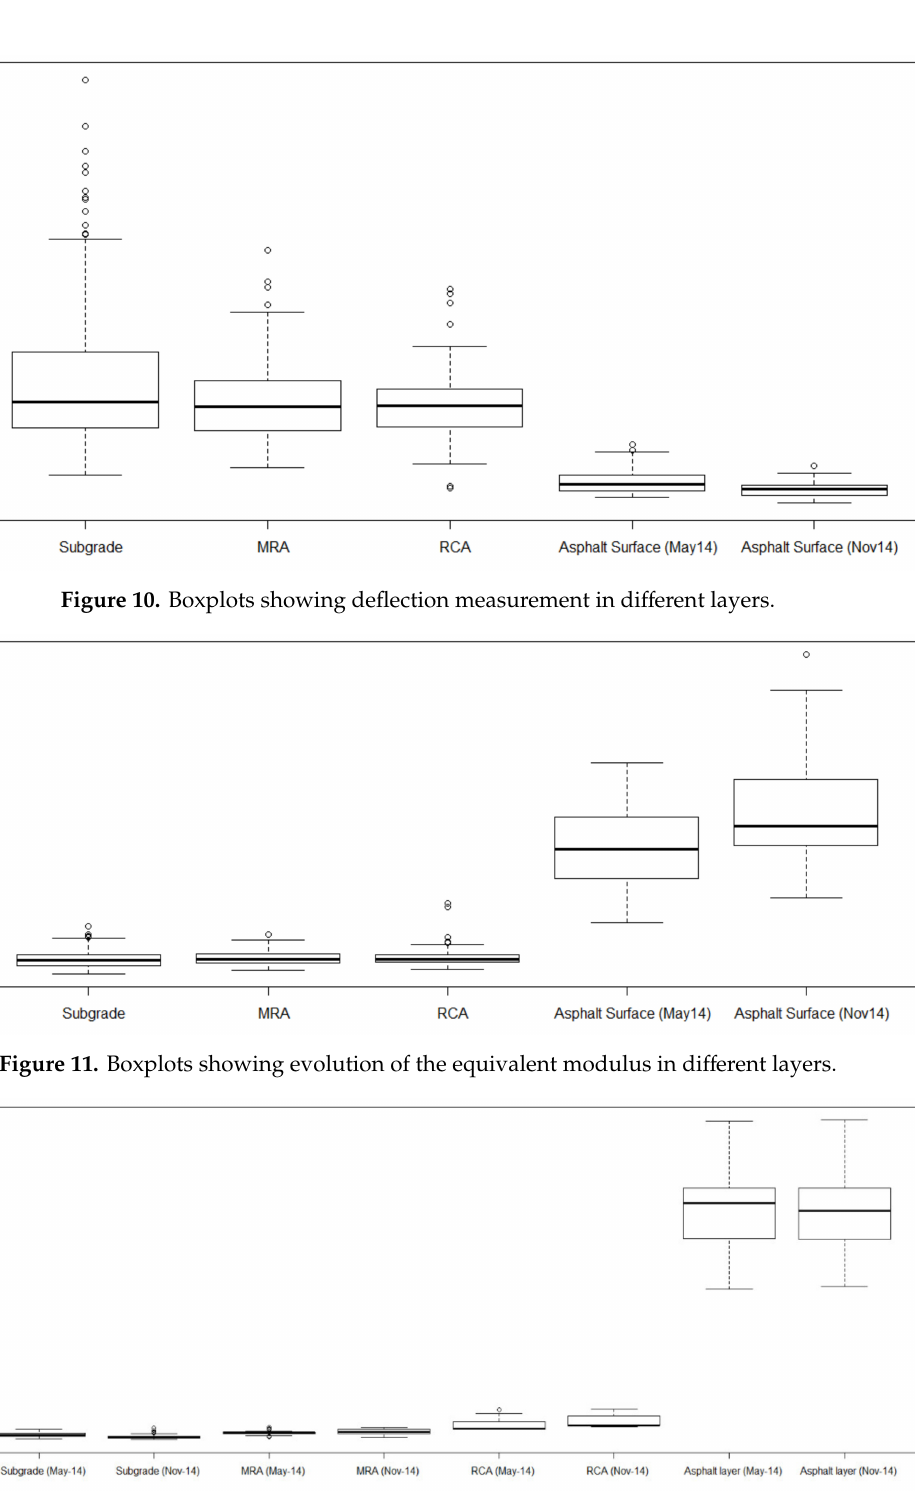
Figure 12. Boxplot of moduli back calculation FWD tests,